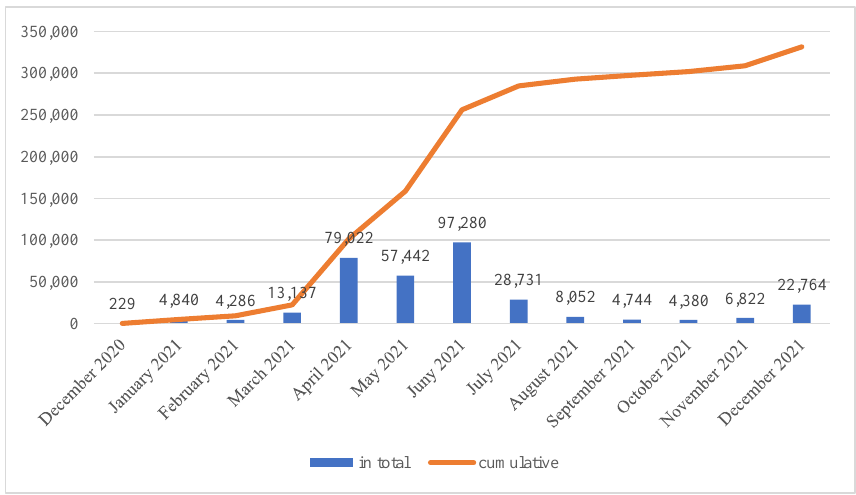
Figure 1. Number of anti-COVID-19 vaccinations performed among Polish soldiers (total and cumulative value).